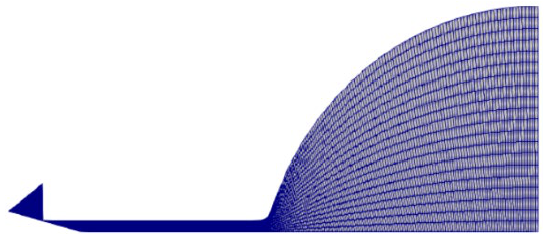
Figure 9. Computational grids. Table 1. Effects of grids on the mean molecular velocity at the nozzle exit.